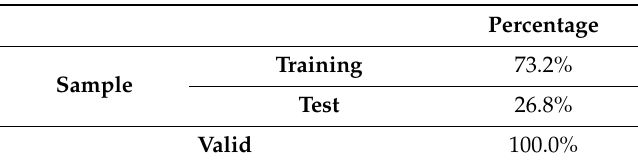
Table 1. Case allocation summary for Volume.